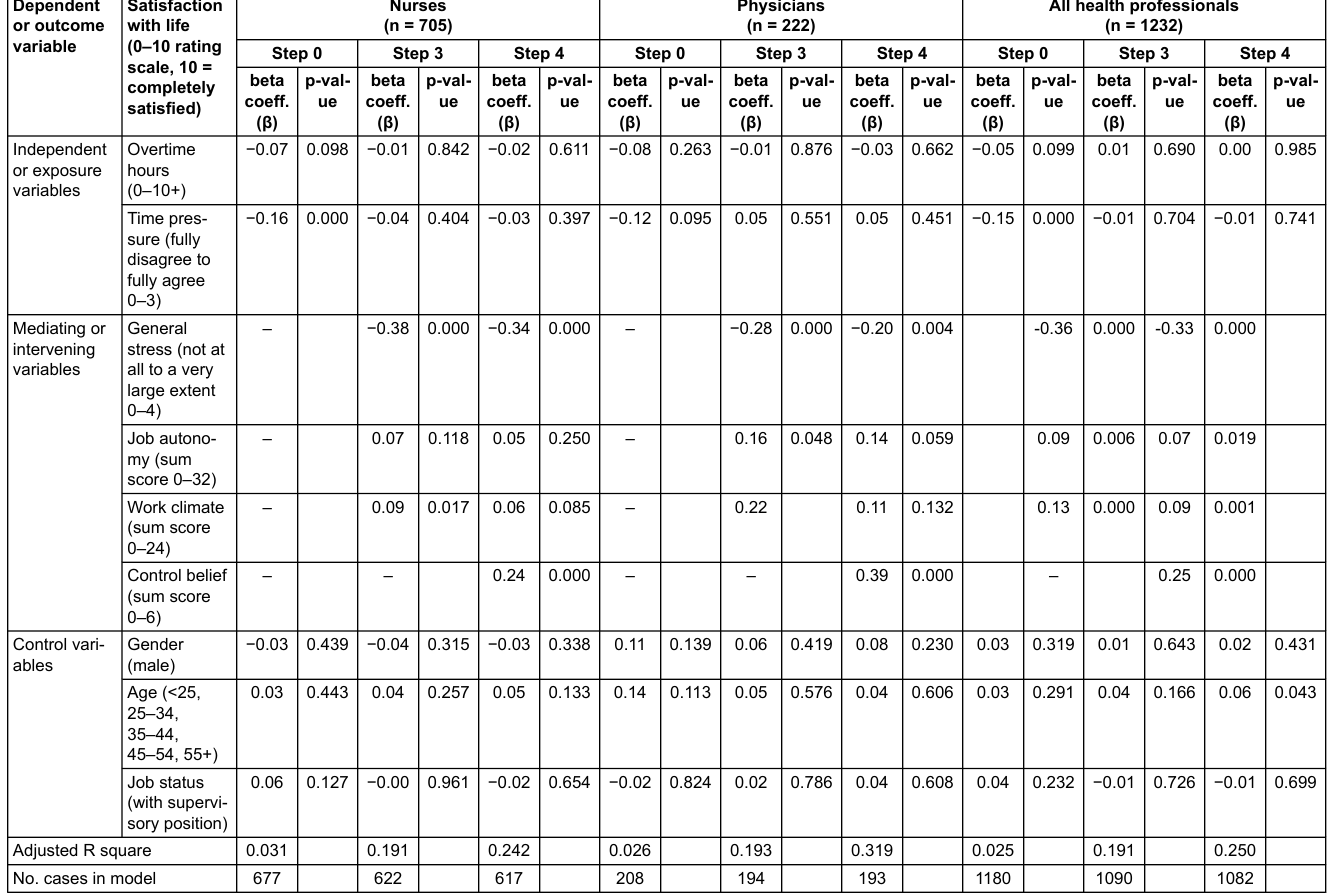
Table 4b: Explaining satisfaction with life among health professionals – results of a stepwise multiple linear regression analysis (step 0, step 3 and 4). Dependent or outcome